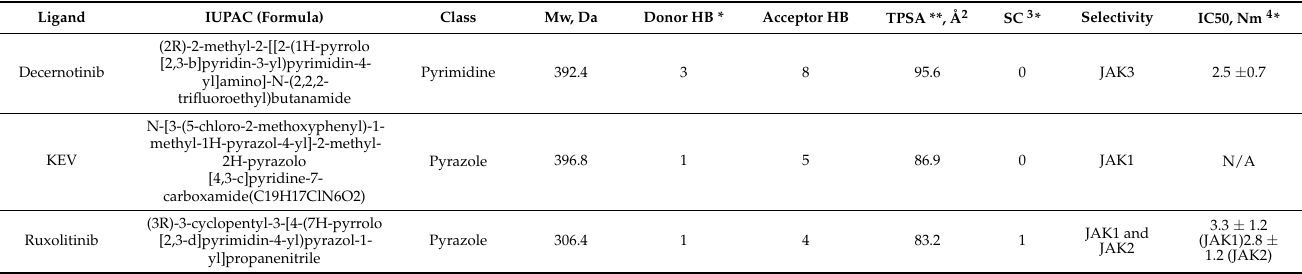
Table 3. Physicochemical properties of the ligands used in the work.